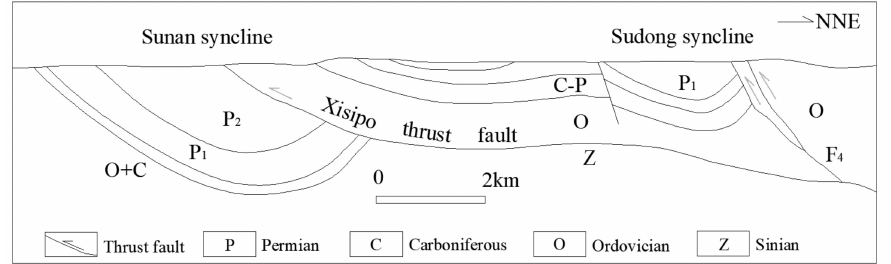
Figure 5. Geological section of the Xisipo thrust fault and its surrounding area. Modified from [50]. As for the Sunan syncline in the south of the mining area, it is in the footwall (i.e., a passive moving wall) of the NW trending Xisipo thrust fault (cf Figure 5). The tectonic compression and shear deformation are smaller than those of the Sudong syncline in the hanging wall. The south end of the Sunan syncline is close to the east–west direction’s